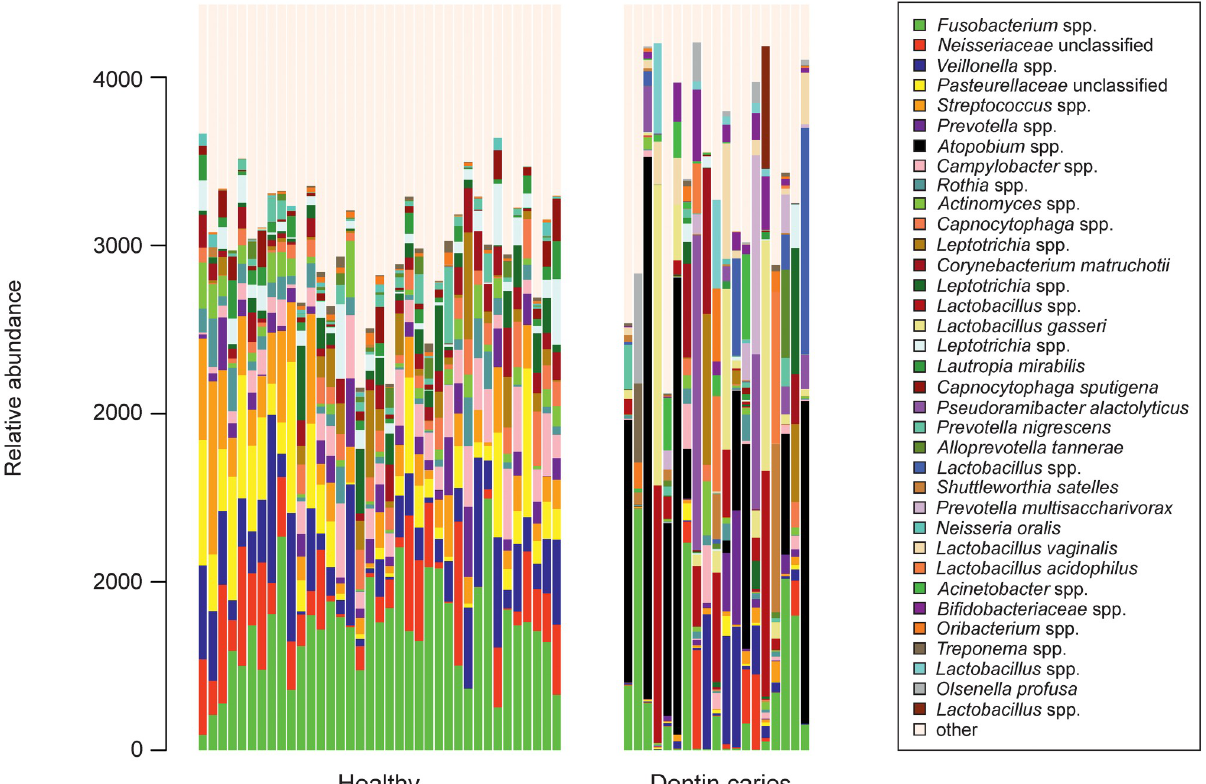
Fig 1. Microbiome structure. Microbiome structure of the 56 oral samples. Only the relative abundance of the 35 more abundant species are plotted, the rest are named “other”.